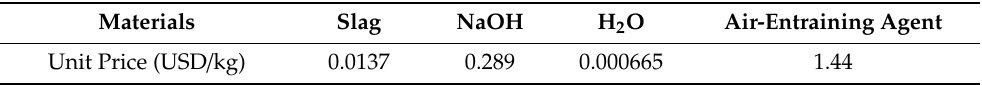
Table 3. The unit price of raw